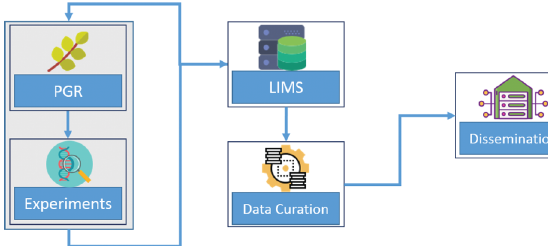
Figure 1: Data processing in LIMS throughout from data-entry to